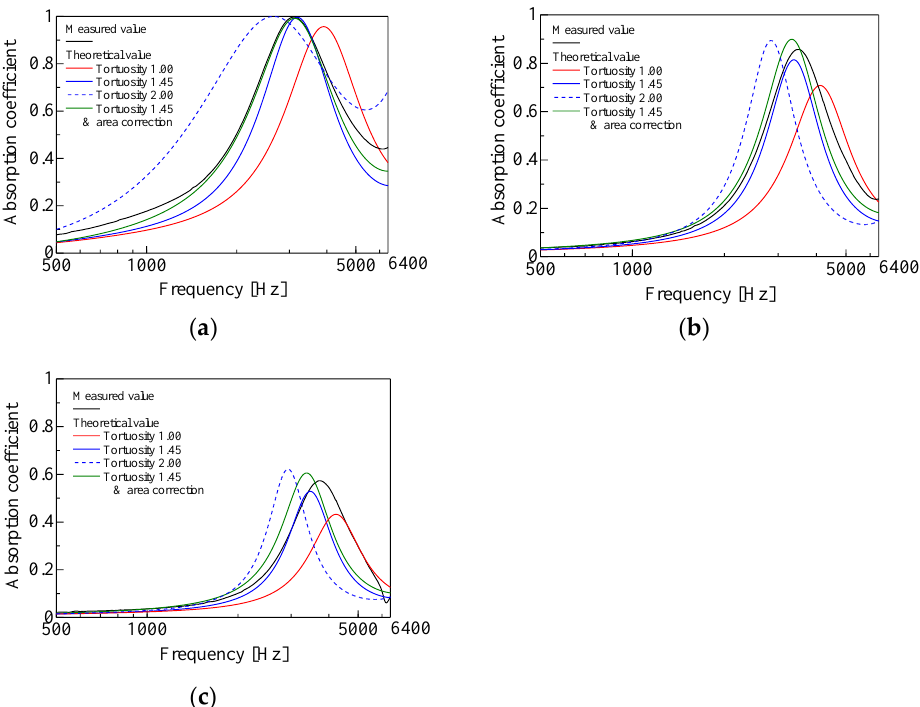
Figure 10. The experiment in comparison with calculation: ( a ) d = 1 mm; ( b ) d = 2 mm; ( c ) d = 4 mm.